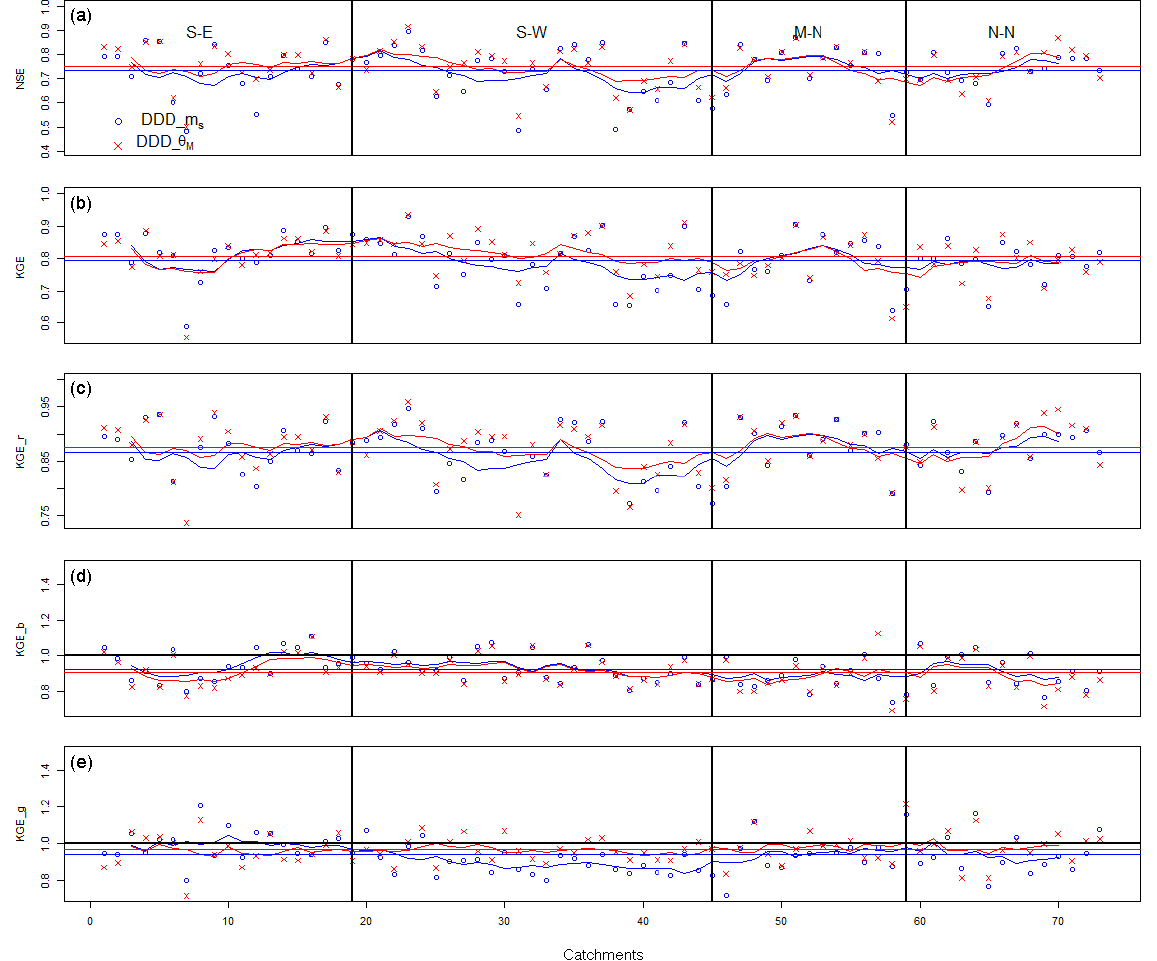
Figure 7. Skill scores for DDD_ m S (blue circles) and DDD_ θ M (red crosses) for 73 Norwegian catchments. Mean skill score values are shown in horizontal lines (same colour code). (a) NSE, (b) KGE, (c) KGE_r (correlation), (d) KGE_b (bias) and (e) KGE_g (variability error) are